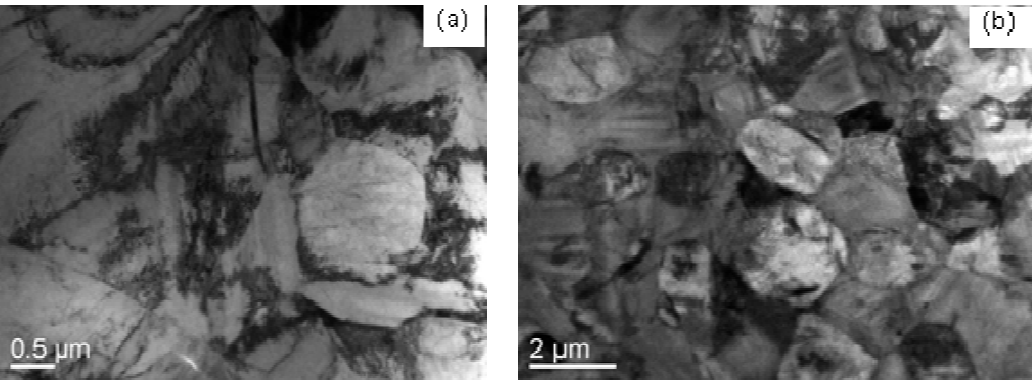
Figure 12. TEM microstructures of the Ti–6Al–4V alloy at 890 °C (ε = 0.6). ( a ) 5 × 10 −4 s −1 and ( b ) 0.05 s −1